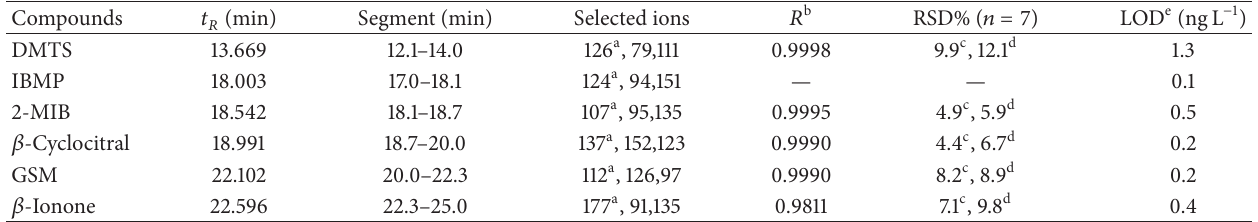
Table 2: The parameters of the MS scan function (SIM mode) for the determination of analytes.